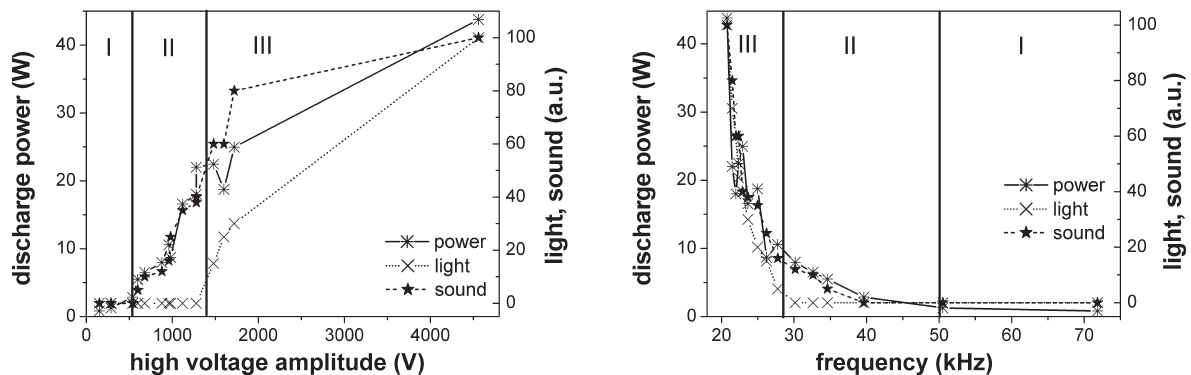
Figure 3: Dependence of discharge power, emitted light and sound on applied high voltage amplitude (left) and frequency (right); NaCl solution (500 µS cm −1 ), dielectric barrier thickness of 0.6 mm, pin-hole diameter of 0.6 mm. I – electrolysis, II – bubble formation, III – regular discharge operation. High frequency is varied from 20 to 72 kHz depending on the high voltage